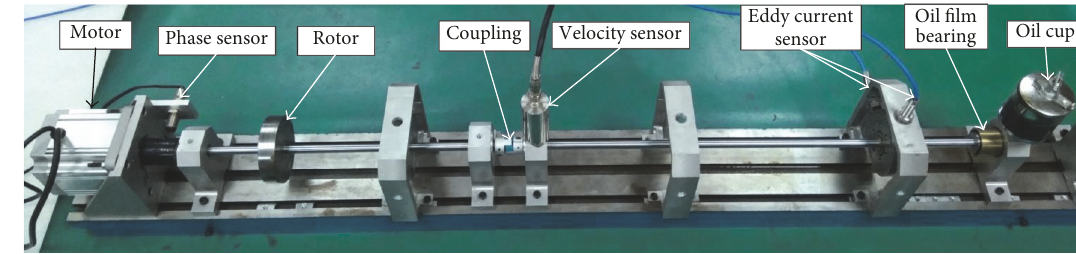
Figure 5: Experimental setup and sensor